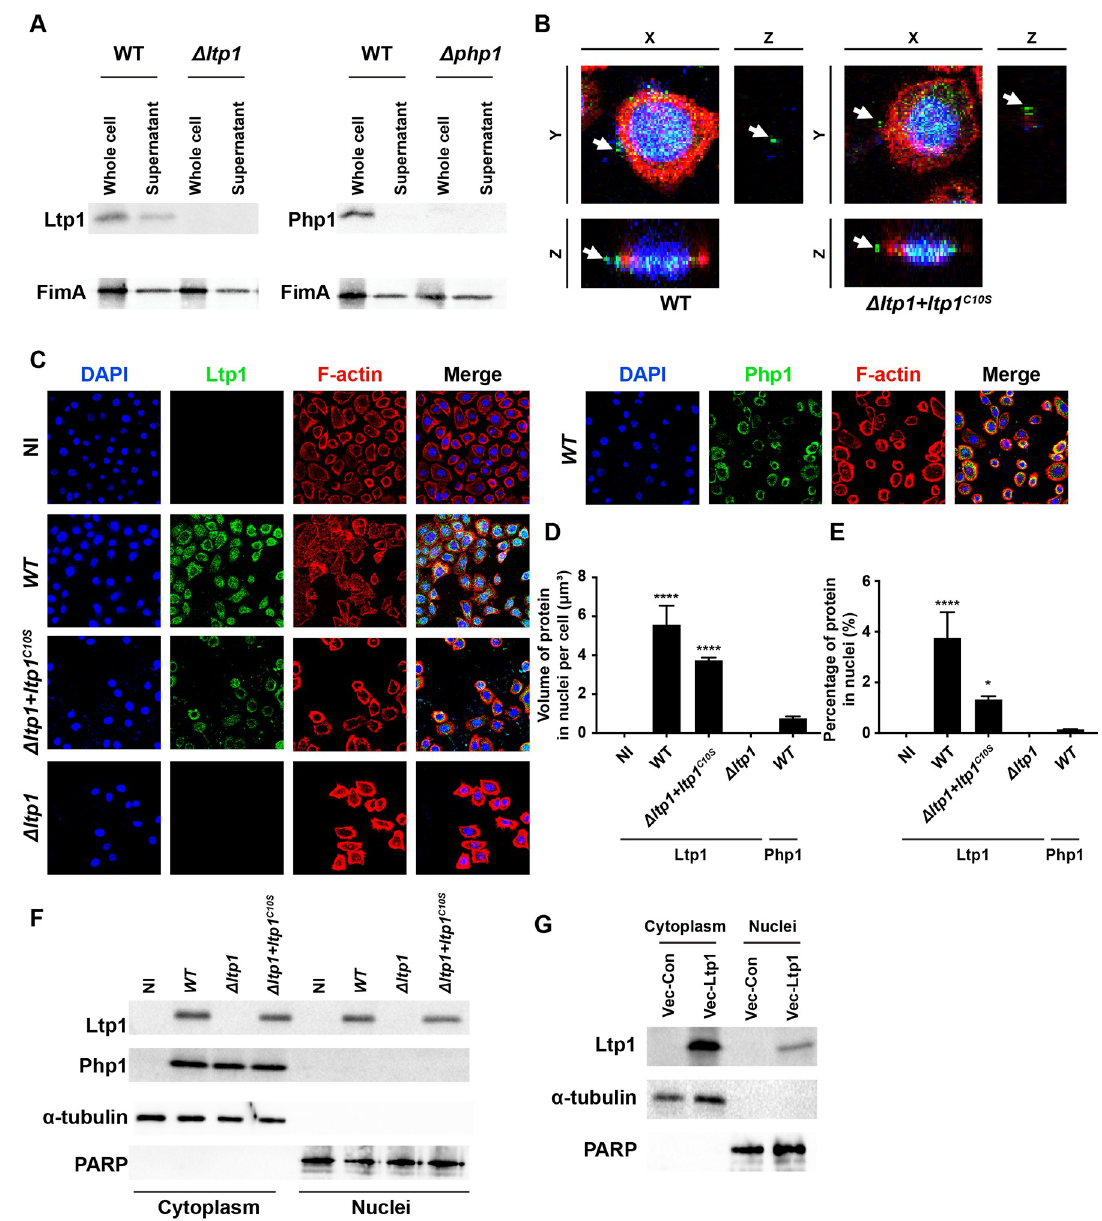
Fig 2. Ltp1 is secreted by P . gingivalis and co-localizes with the nucleus. A) Western blots of whole-cell lysates or culture supernatants of P . gingivalis WT, Δ ltp1 , or Δ php1 , probed with antibodies to Ltp1, Php1, or FimA as a control for a secreted protein. B). Fluorescent confocal microscopy of TIGK cells challenged with P . gingivalis WT or Δ ltp1 + ltp1 C10S . Cells were probed with Ltp1 antibodies and Alexa Fluor 488 secondary antibody (green). Actin (red) was stained with Texas Red-phalloidin, and TIGK and P . gingivalis DNA stained with DAPI (blue). Cells were imaged at magnification × 63, and shown are digitally reconstructed images (x-z section; and z-projection of x-y sections) generated with Volocity. Arrows indicate areas of secreted Ltp1. C) Fluorescent confocal microscopy of TIGK cells challenged with P . gingivalis WT, Δ ltp1 , Δ php1 , Δ ltp1 + ltp1 C10S , or left uninfected (NI). Cells were probed with Ltp1 or Php1 antibodies as indicated, and Alexa Fluor 488 secondary antibody (green). Actin (red) was stained with Texas Red-phalloidin, and nuclei (blue) stained with DAPI. Cells were imaged at magnification × 63, and shown are projections of z-stacks generated with Volocity. D) Volume and E) Percent co-localization of Ltp1 or Php1 in the nuclear region of the images in (C) � p < 0.05, ���� p < 0.001 compared to NI. F) Western blots of cytoplasmic or nuclear fractions of TIGKs challenged with P . gingivalis WT, Δ ltp1 , Δ php1 , Δ ltp1 + ltp1 C10S , or left uninfected (NI). Blots were probed with antibodies to Ltp1, Php1, α -tubulin (cytoplasmic control) or PARP (nuclear control). G) Western blots of cytoplasmic or nuclear fractions of TIGKs transiently transfected with Ltp1 (Vec-Ltp1), or empty vector control (Vec-Con). Blots were probed with antibodies to Ltp1, α -tubulin (cytoplasmic control) or PARP (nuclear control).